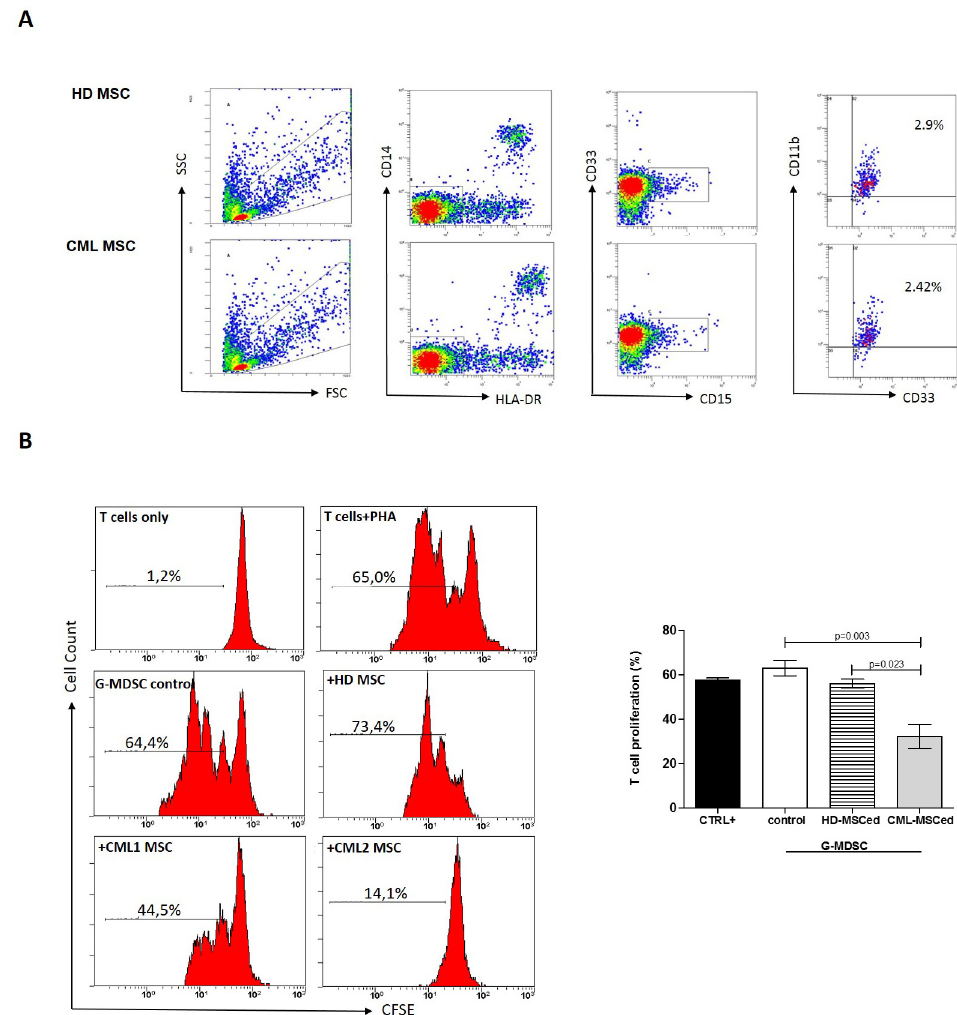
Fig 2. CML-MSC-educated G-MDSC are immunosuppressive. A. HD- and CML-MSC generate similar amount of G-MDSC. The figure shows a representative data from one experiment. Flow cytometry analysis was performed with gates set on CD11b+CD33+CD15+CD14-HLADR- cell population. B. MSCedG-MDSC were analyzed for their immunosuppressive activity against autologous T cells. Representative flow cytometry dot-plots show the gating strategy for each experimental condition. Only CML-MSCedG-MDSC exhibited suppressive effects compared to G-MDSC control. The data represent mean ± SD of all analyzed co-cultures in